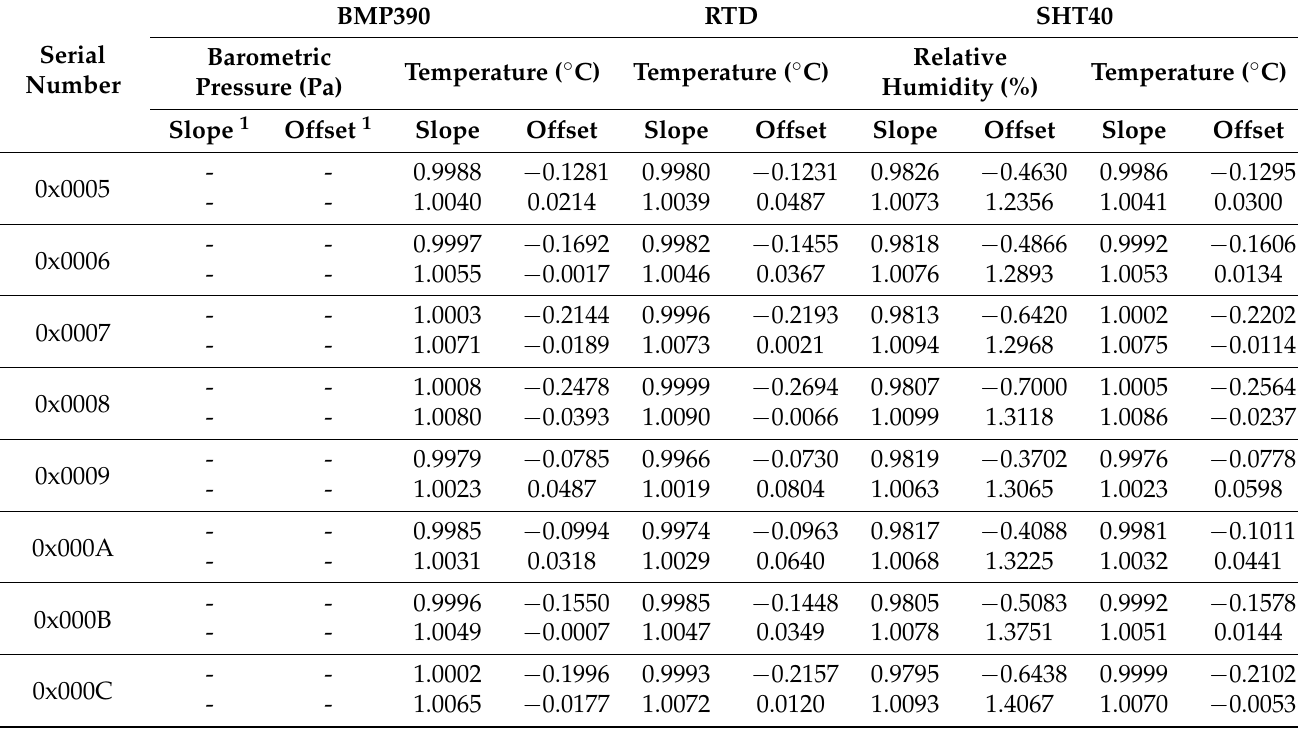
Table 11. Lower and upper bounds of the 95% confidence interval for calibration